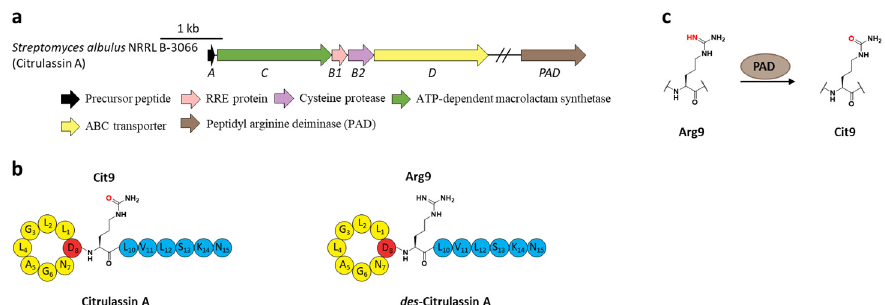
Figure 8. The BGC, structure, and conversion of citrulassin A. ( a ) The BGC of citrulassin A. The pad gene is distantly encoded in the genome. ( b ) The structures of citrulassin A and des -citrulassin A. The oxygen atom in Cit9 is highlighted in red. ( c ) PAD catalyzes the deimination of Arg9 to generate